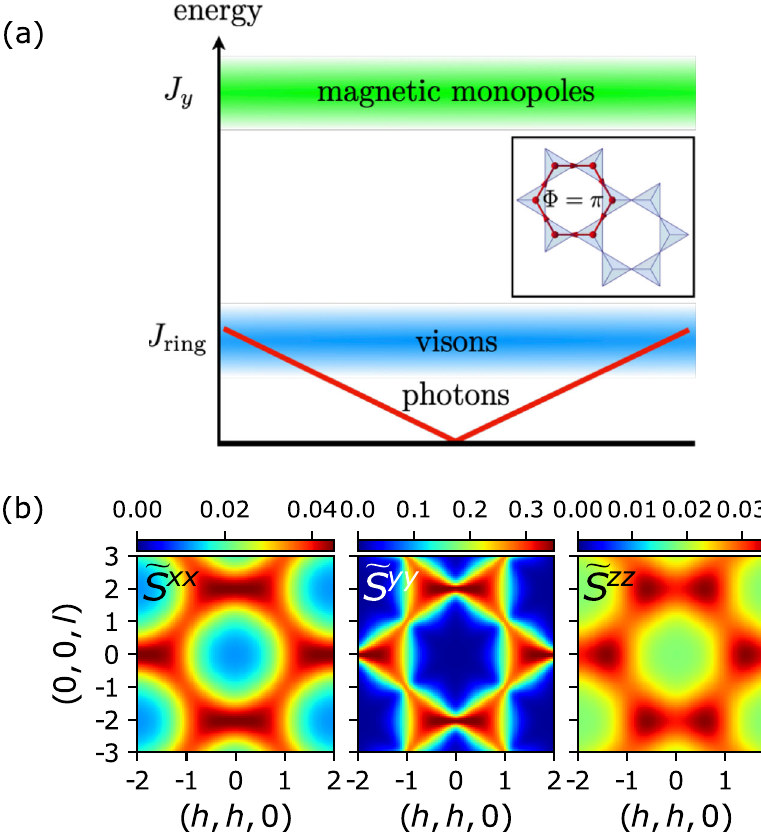
Fig. 3 Properties of the octupolar quantum spin-ice state. a Schematic depiction of the energy spectrum of π -OQSI state, with the green band denoting the spin- fl ip excitations that create a pair of magnetic monopoles (spinons). The blue band represents the dispersive, gapped vison excitations, which are analogous to electric charges. The red line is the hallmark of gauge-neutral photon excitations of the quantum spin-ice, except here the octupolar (rather than dipolar) character renders the photons “ invisible ” to neutrons. Inset, Representation of the gauge fl ux Φ through the hexagon formed by 6 corner-sharing tetrahedra on the pyrochlore lattice. b The diagonal pseudospin correlation αβ ð q Þ de fi ned in the main text). Here x , y , z are the local axes (relative to the local ^ z ¼ ½ 111 (cid:2) direction). The pinch- functions ~ S xx , ~ S yy , and ~ S zz (see ~ S point patterns in the ~ S yy channel are invisible to neutrons because of the octupolar nature of s y